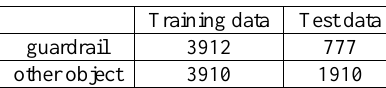
Table 1. The number of sliced segments